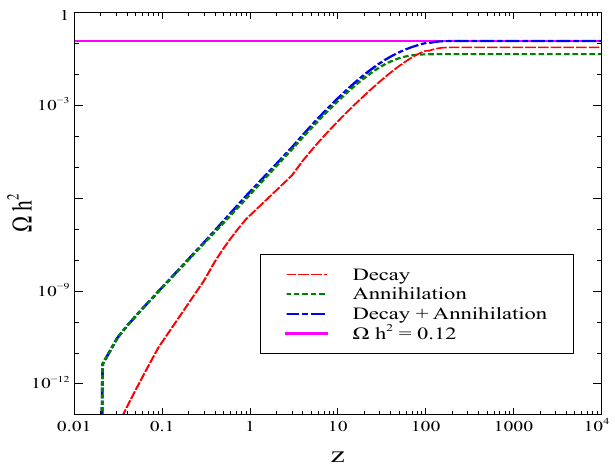
Figure 6 . Variation of relic density contributions of the single DM component scenario as a function of z . Here, M = 10 keV, M Z 0 = 10 GeV, g 0 = 1 : 0 (cid:2) 10 (cid:0) 9 , M h S 1 1 (cid:11) = 0 : 01 rad. dashed line) and annihilation (green dotted line). Here, for a suitably selected set of